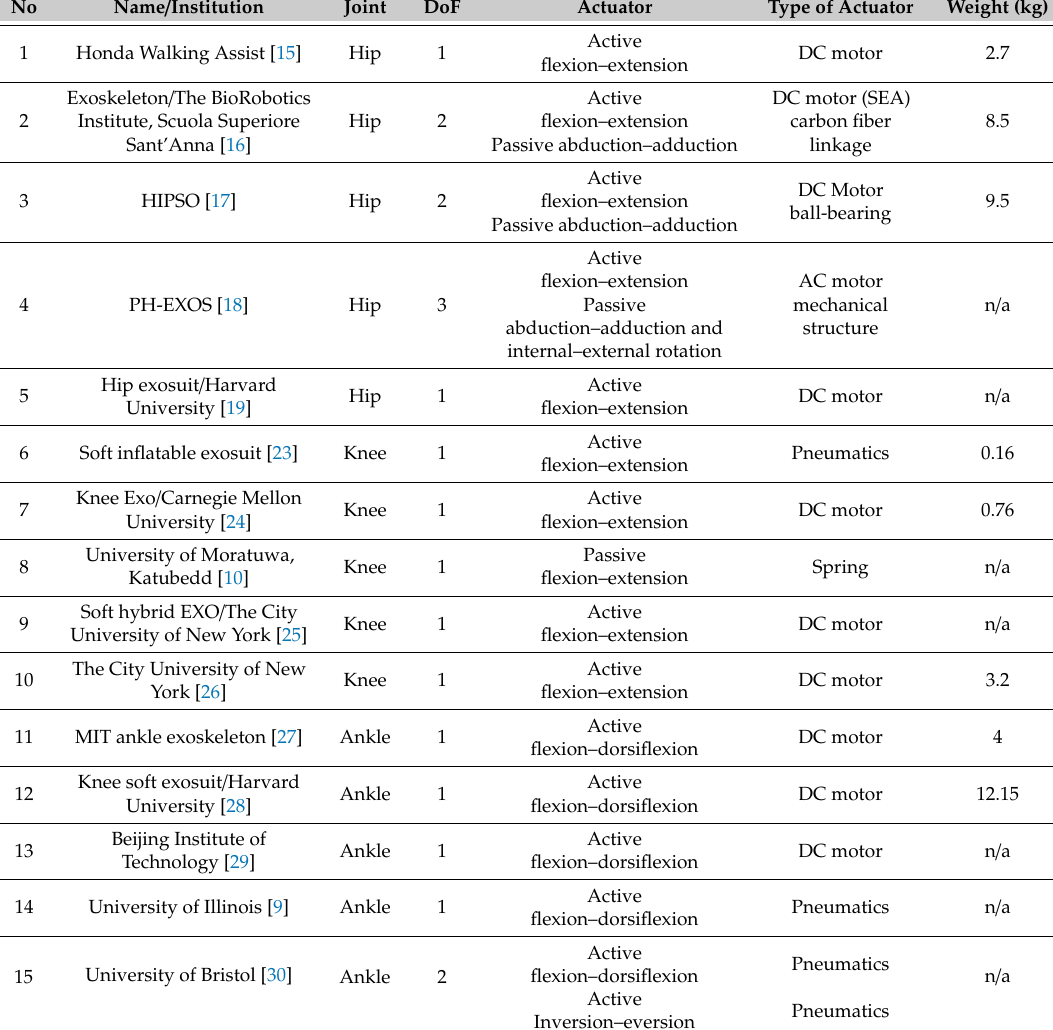
Table 3. Actuators in joints of lower limb